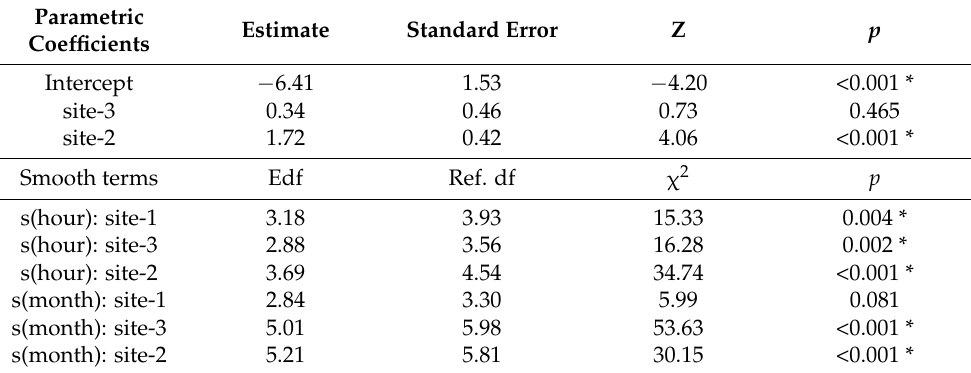
Table 7. The table below summarizes a negative binomial GAM model used to examine the effect of recording time and month on C. coromandus ’s activity. The recording hour and month were modeled independently with smoothed function for each monitored site, while the cyclic predictor was modeled using a cyclic cubic regression spline. Reference degrees of freedom was used to calculate test statistics and p -values are represented by Ref. df, whereas Edf (Effective degrees of freedom) indicates the curviness of the